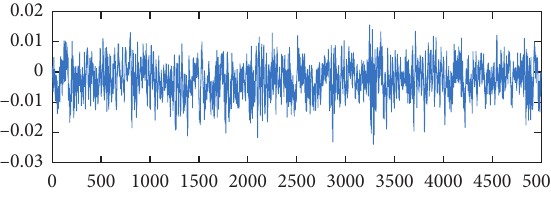
Figure 23: A normal vibration signal